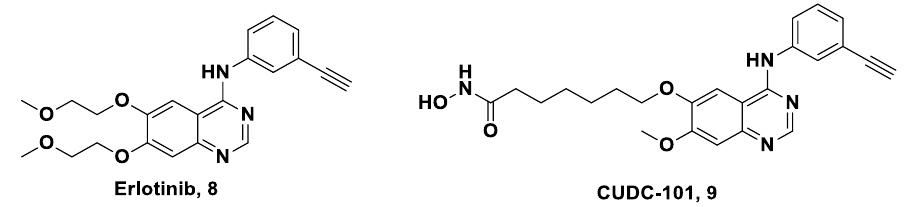
Figure 2. HDAC inhibitors with Erlotinib-based conjugates using SAHA as lead compound.